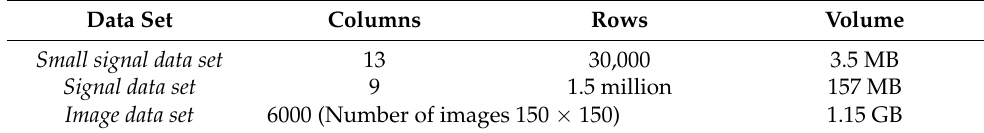
Table 4. Experiment data